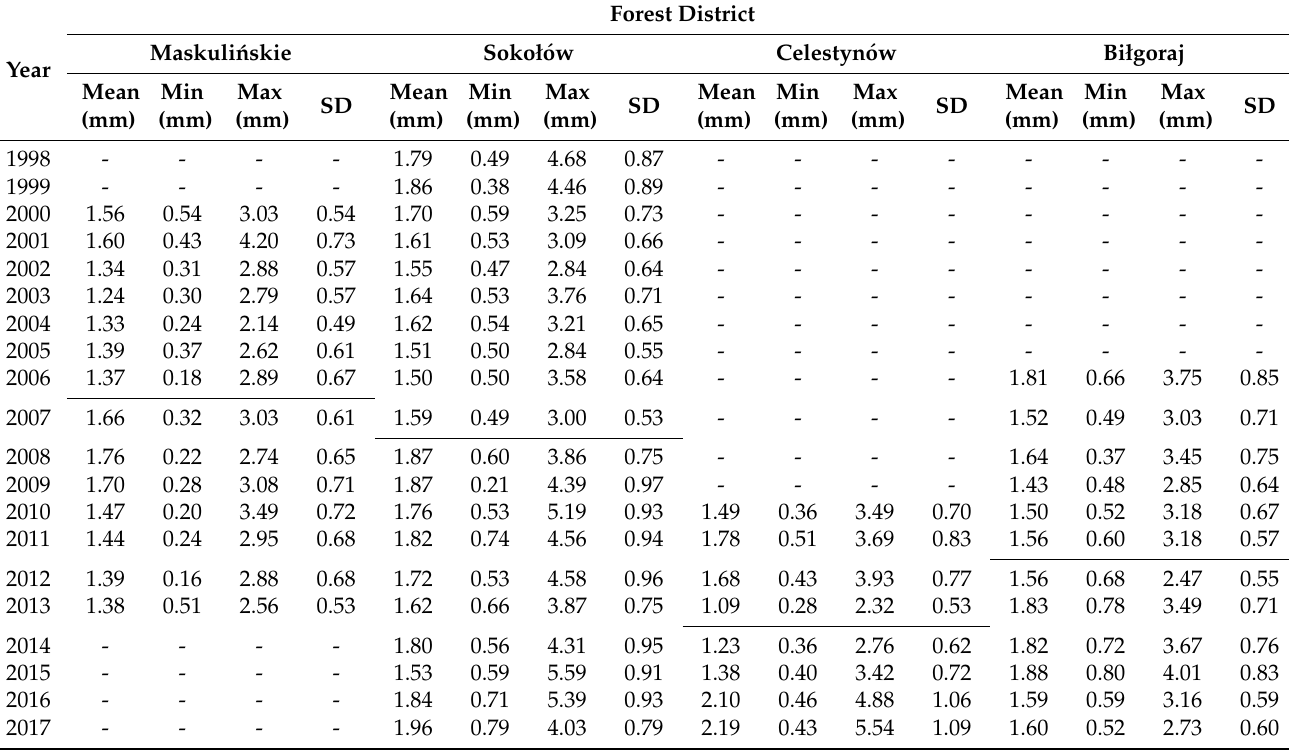
Table 4. Descriptive characteristics of the analyzed tree-ring